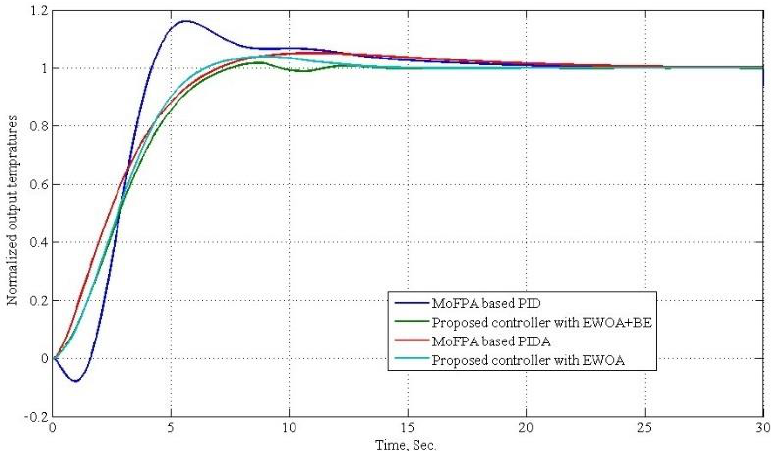
Figure 6. System dynamic performance of the first scenario.